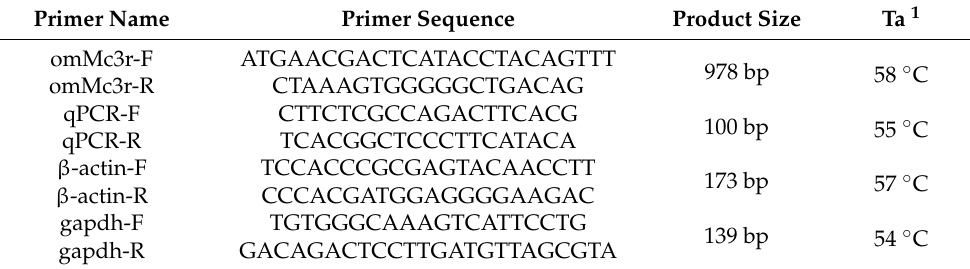
Table 1. Primers for molecular cloning and real-time quantitative